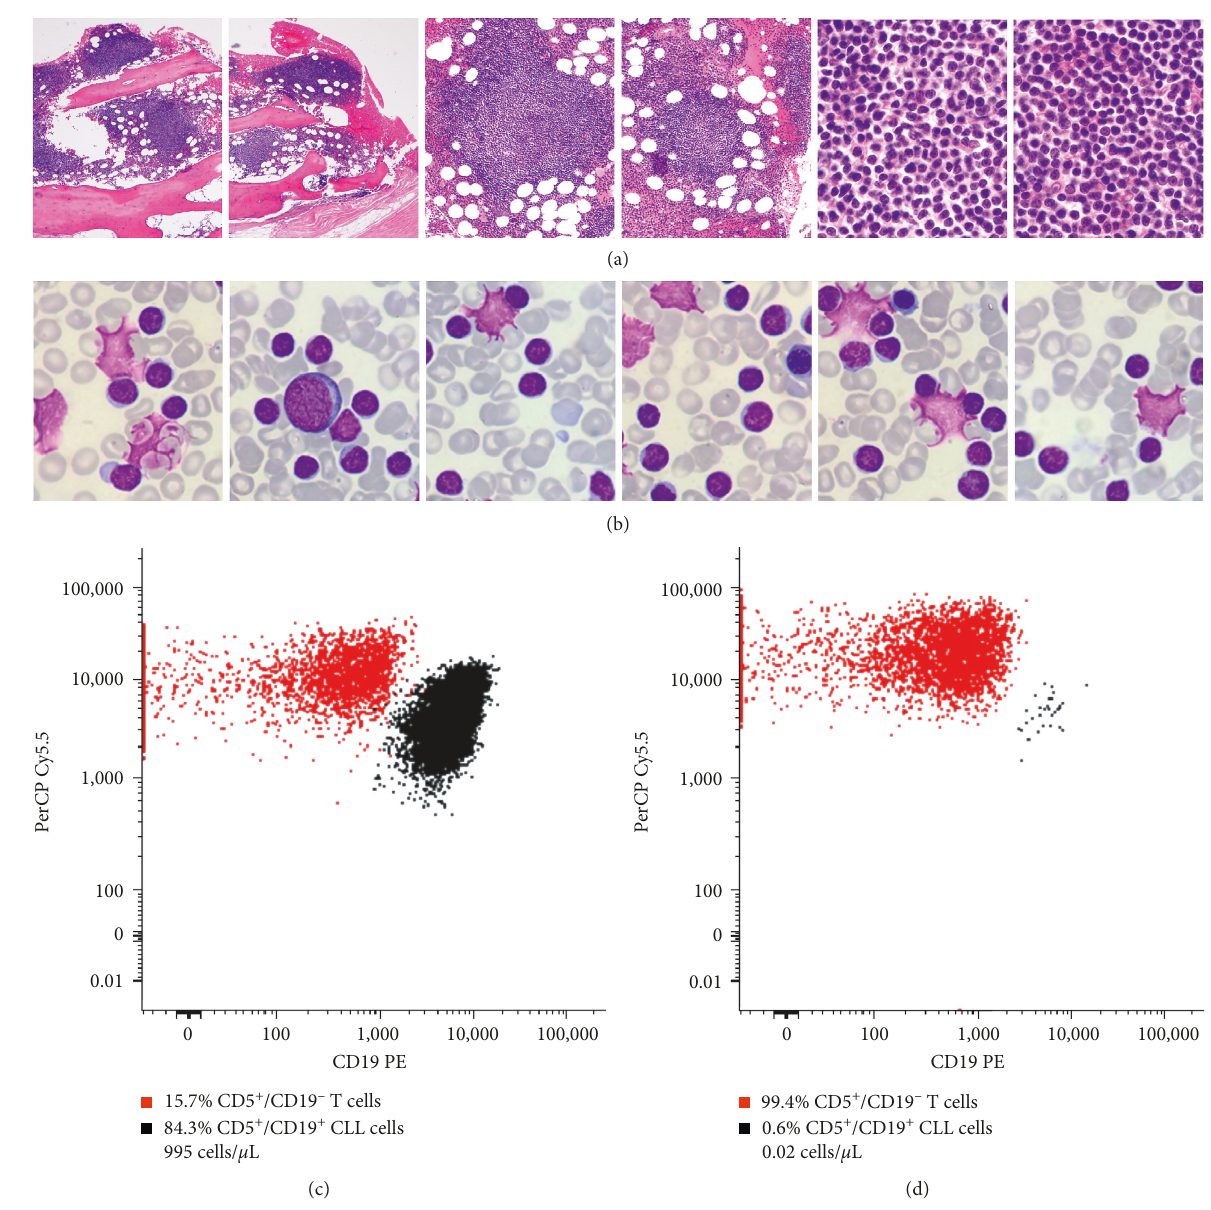
Figure 1: B-CLL characterization. (a) Bone marrow biopsy (HE): in September 2015, there was a 70% nodular and interstitial infiltration of small lymphocytes. (b) Bone marrow smear (MGG): in January 2016, numerous small lymphocytes, with clumped chromatin and scanty cytoplasm, smudge cells, and a few erythroblasts were detected. Dot plots illustrating cerebral spinal fluid (CSF), immunophenotyping CD5 + /CD19 (red dots) and CD19 + /CD5 + B-CLL cells (black dots) in October 2015 (c) and in August 2017 (d). Magnification: (a) 600 (right) and (b) × ×